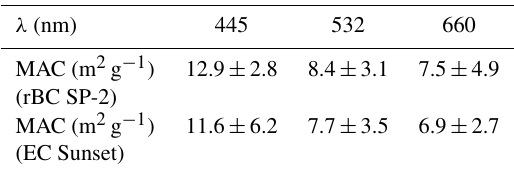
Table 3. Specific absorption cross section (MAC) values deter- mined from photoacoustic, SP-2 incandescence, and thermo-optical measurements for 31 October 2012 (24h average) at Durlacher Tor,